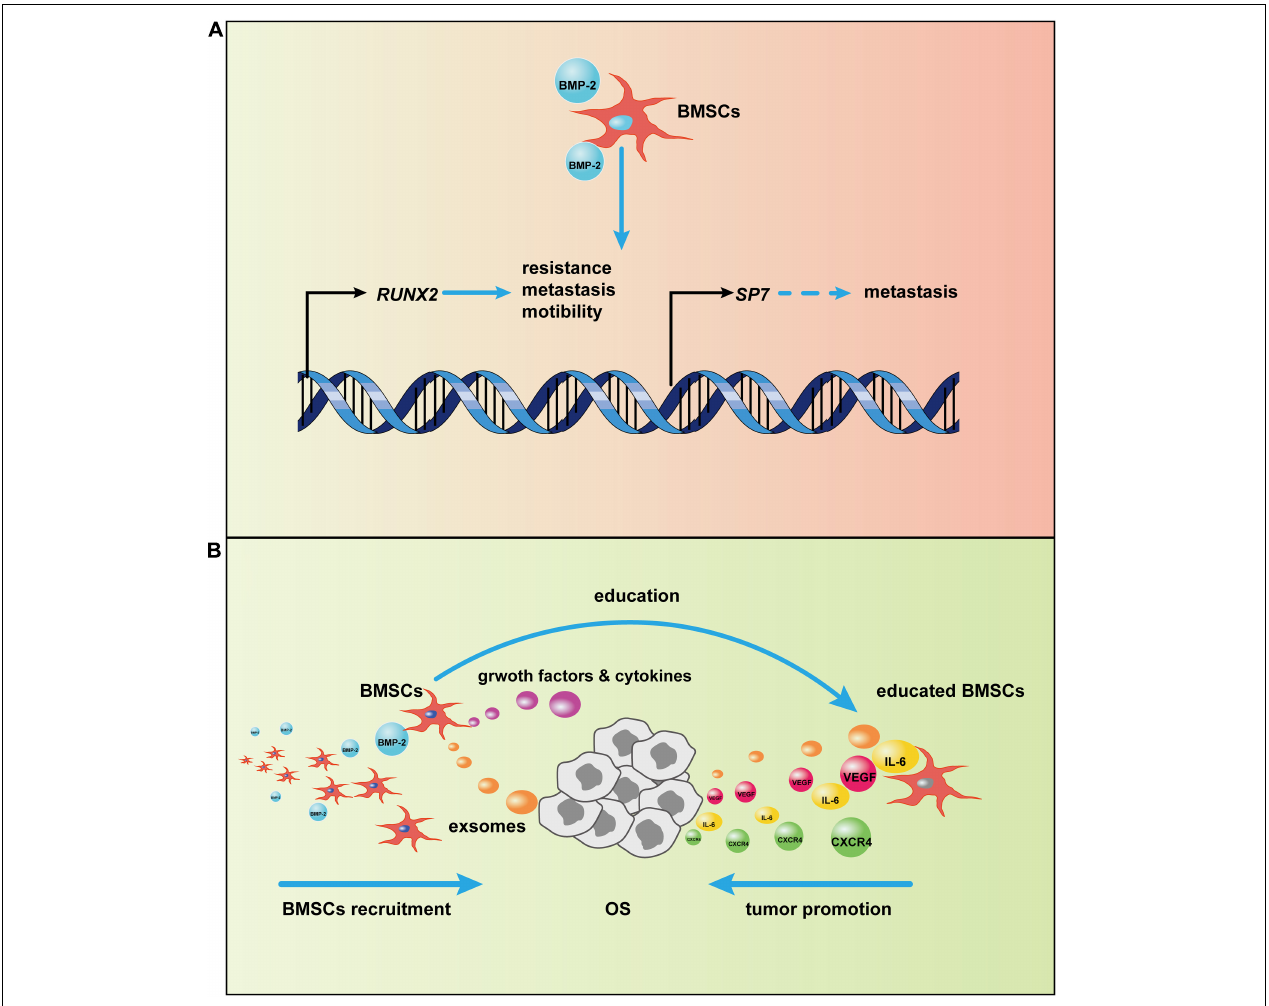
FIGURE 4 | Potential mechanism of bone morphogenic protein-2 (BMP-2)–induced tumor progression via bone marrow-derived mesenchymal stem cells (BMSCs). (A) After the canonical BMP-2 pathway is activated, RUNX2 and SP7 transcription initiate. The overexpression of RUNX2 and SP7 , as a result of continuous activation of the canonical BMP-2 pathway, may promote osteosarcoma (OS) progression. (B) BMSCs are recruited to OS by BMP-2. Then, BMSCs adapt to OS via OS-related cytokines and exosomes; in turn, the tumor-centered BMSCs will secrete growth factors and cytokines, such as vascular endothelial growth factor (VEGF) and CXC chemokine receptor 4 (CXCR4), to promote OS